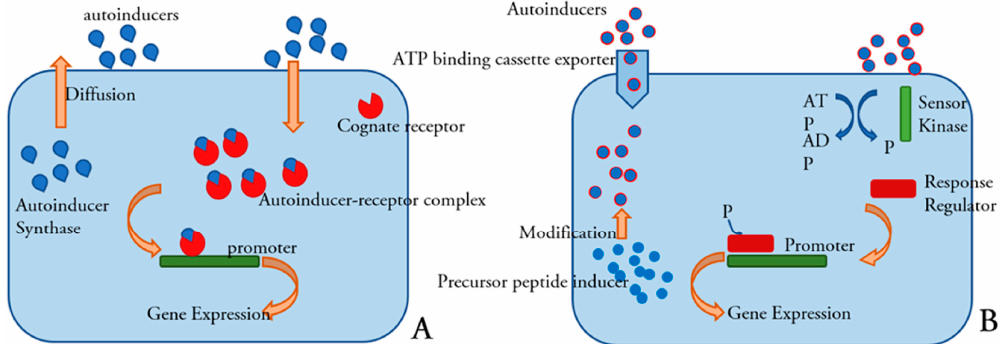
Figure 4. General scheme of quorum sensing in Gram-negative ( A ) and Gram-positive ( B ) bacteria [155]. Reproduced with permission.